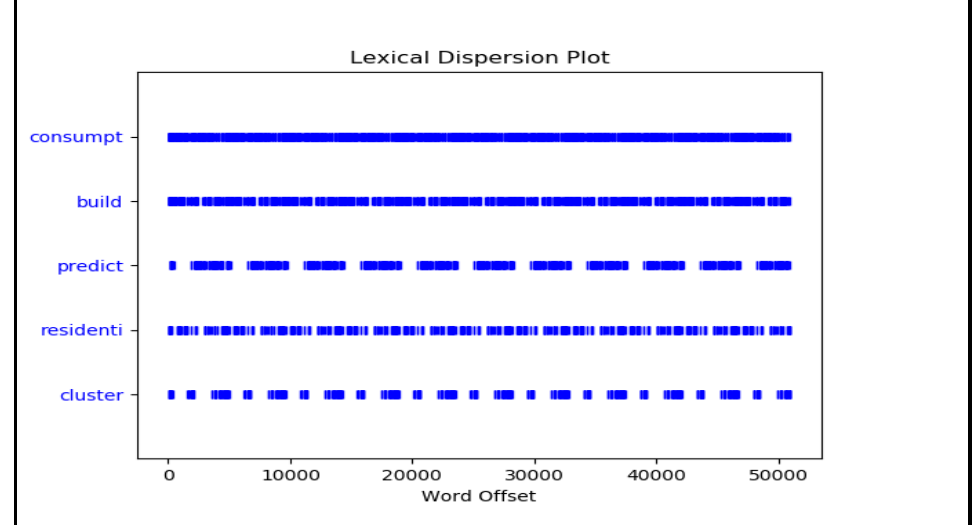
Figure 5. Word offset plot for the top 5 words ranked by frequency.